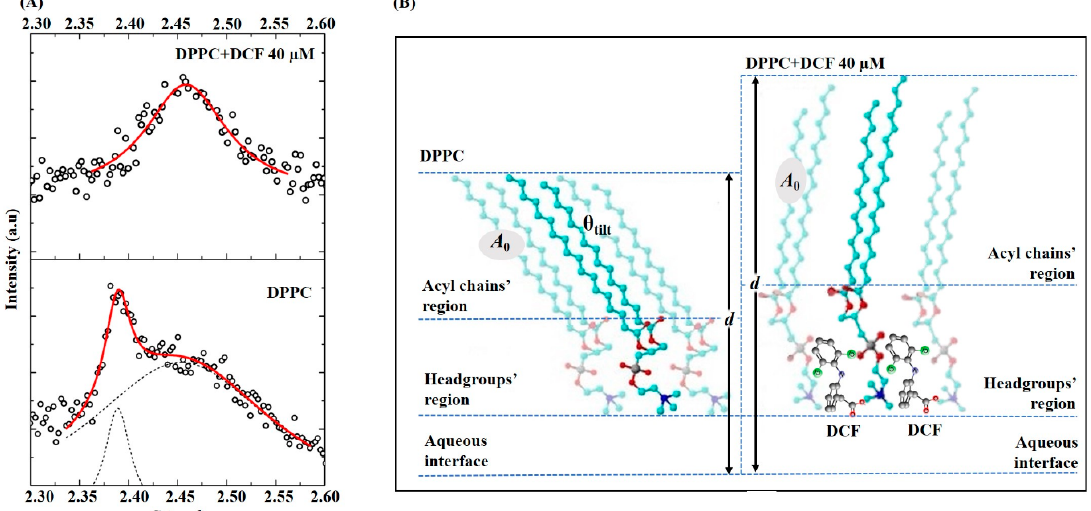
Figure 7. ( A ) WAXS patterns recorded in static exposures at 20 °C and at pH 5.0 for multilayers of DPPC in the absence (lower figure) and presence of DCF. Solid red lines give the best fit of the Lorentzian’s analysis model to the scattered intensities. ( B ) Schematic representation of the effect of DCF penetrating the headgroup region of DPPC causing the loss of tilt angle with consequent increase of the long spacing ( d ) and decrease of cross-sectional area ( A 0 ) of the aliphatic lipid chain.